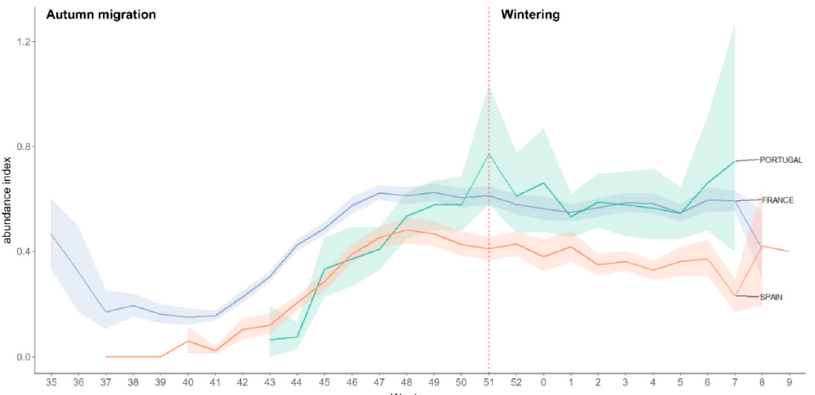
Figure 3. Variation in the relative abundance (average and respective 95% confidence interval—shaded) of Woodcock throughout the hunting season (September to February) for each country, considering the aggregate set of hunting seasons (2009/2010 to 2017/2018). The red dashed line indicates the separation between the periods of autumn migration (left) and wintering (right).